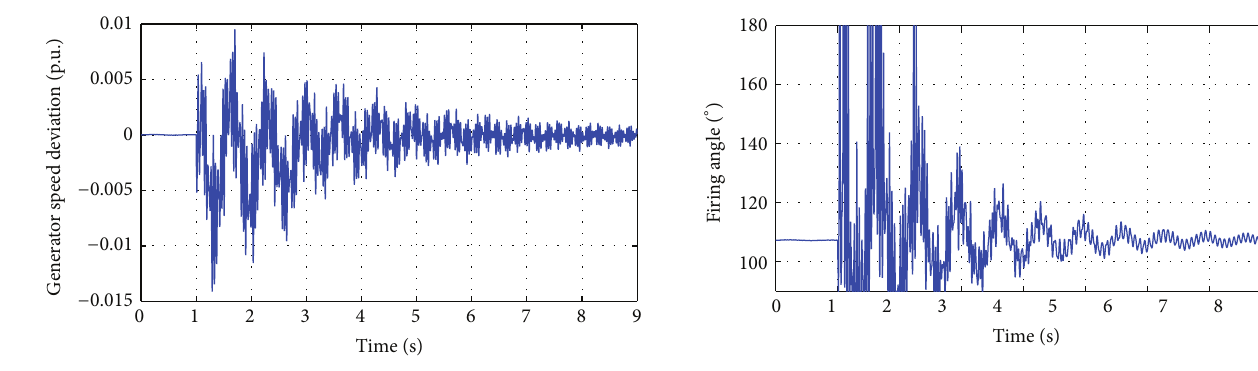
Figure 10: The generator speed deviation with SVC optimized by PSO algorithm.